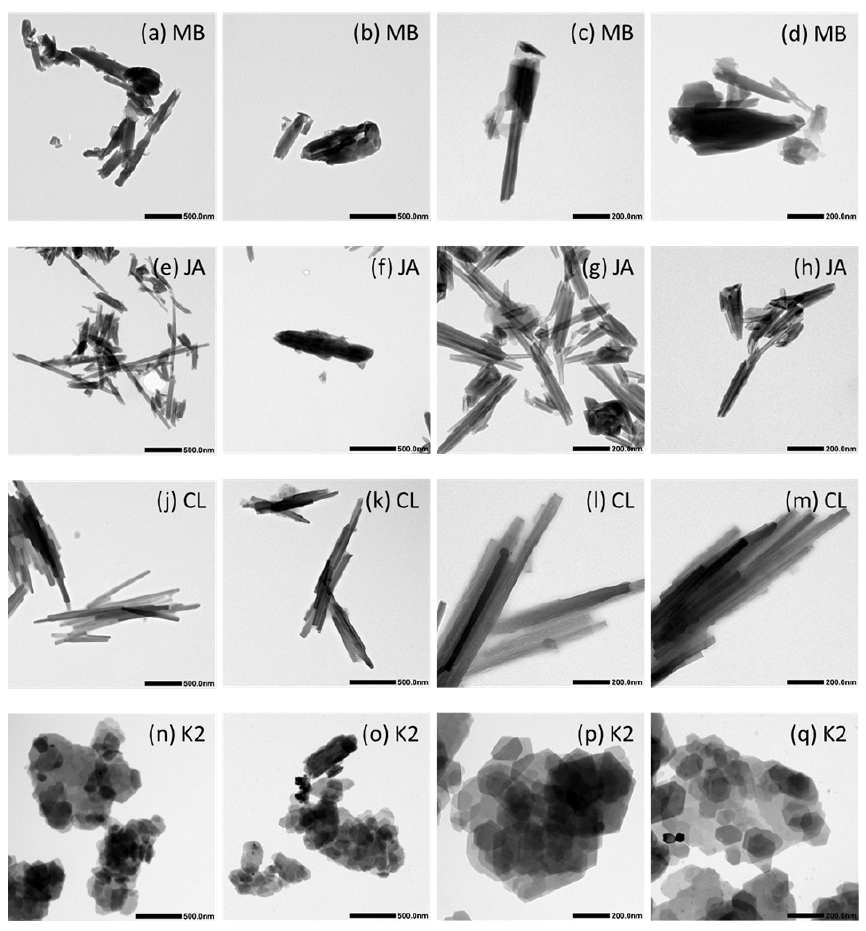
Figure 9. Transmission electron microscopy (TEM) micrographs of untreated samples at two different magnifications (see length bars within the images). Dust sample codes are identical to those in Fig.